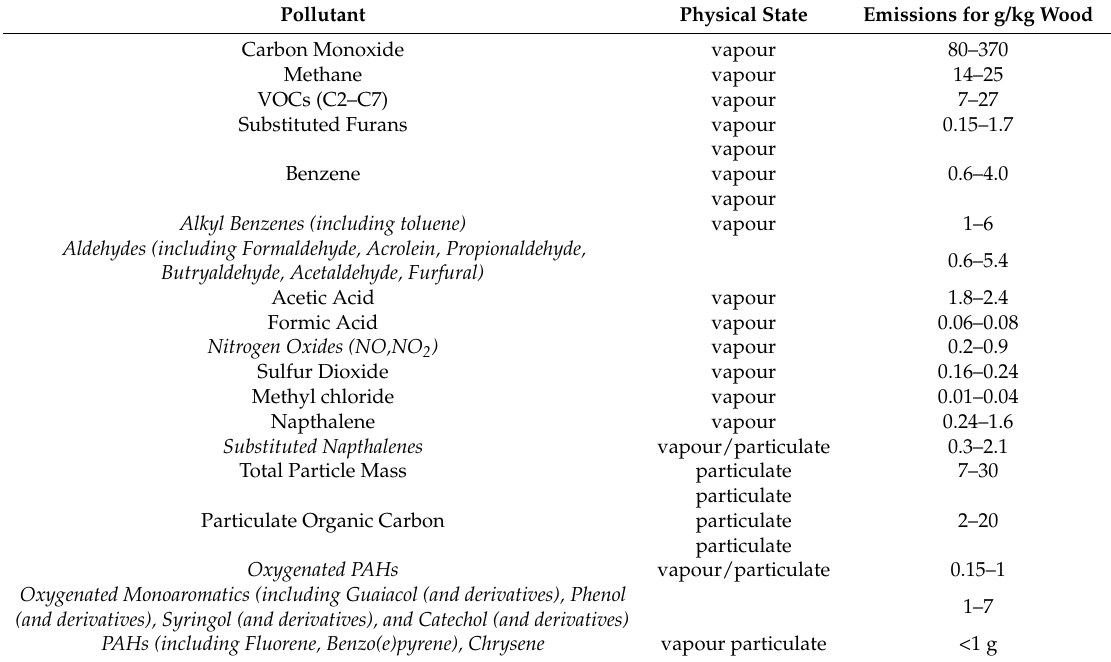
Table 1. The most abundant constituents of wood smoke adapted from